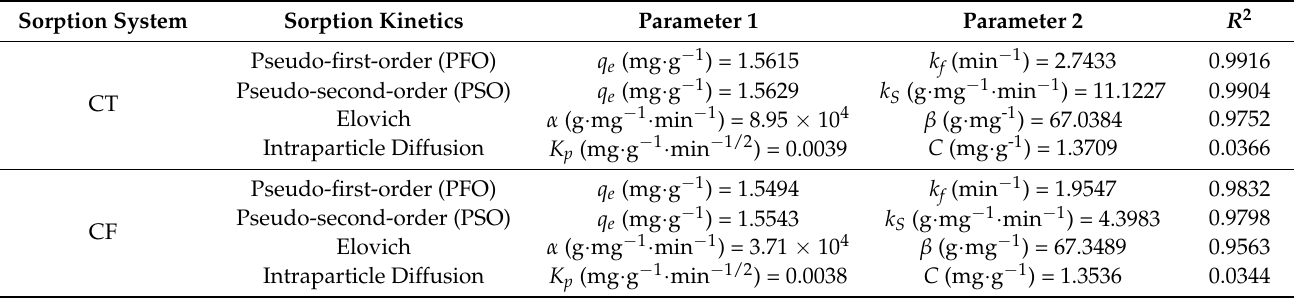
Table 1. Results of sorption kinetic models of Sr sorption on CT and CF.